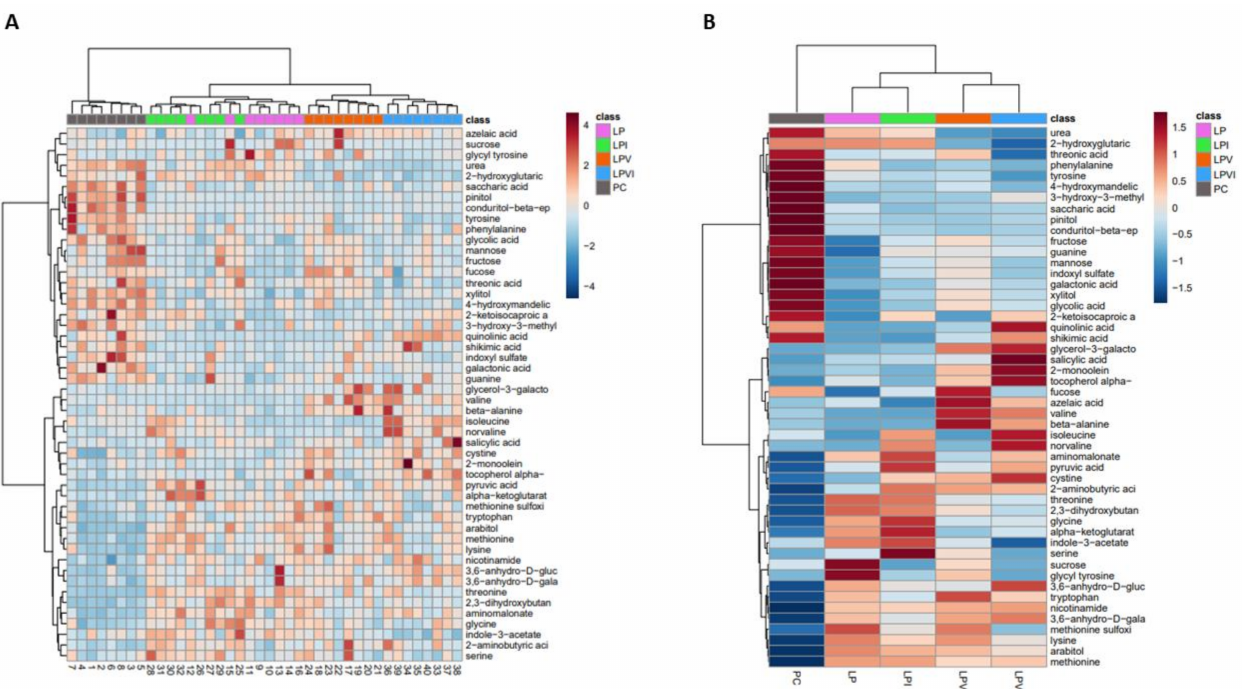
Figure 8. Heatmap analysis of plasma metabolites in nursery pigs fed with very-low-protein diets supplemented with Ile, Val, or combination of both. Hierarchical clustering of the top 50 significant plasma metabolites among: ( A ) individual pigs and ( B ) pigs fed with PC, LP, LPI, LPV, and LPVI. PC (positive control): standard-protein diet; LP (negative control): low-protein diet containing limiting amino acids (i.e., Lys, Met, Thr and Trp) at NRC (2012) levels; LPV: LP containing Val at NRC level; LPI: LP containing Ile at NRC level; LPVI: LP containing Val and Ile at NRC levels. The metabolites are shown in rows, and pigs or experimental groups are shown in columns (Figure 8A,B, respectively). The dark red or blue is corresponding to the magnitude of difference when compared with the average value. The dendrogram on the left side of the heatmap shows both the similarity and the order that the clusters were formed. n =